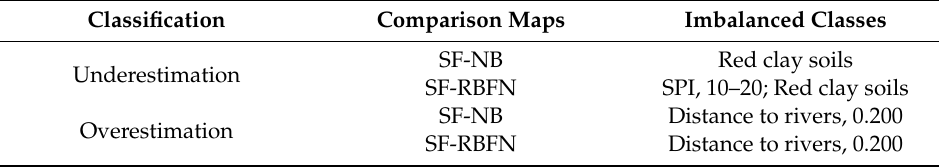
Table 5. Imbalanced class causing spatial distribution of underestimation and